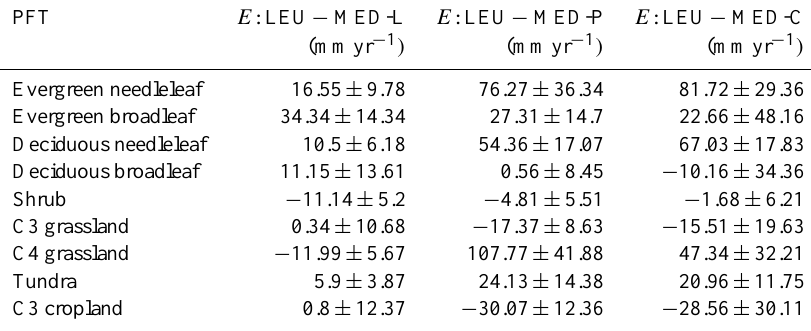
Figure 9. Latitudinal average (December-January-February: DJF and June-July-August: JJA) of mean annual (a, b) gross primary produc- tivity (GPP) and (c, d) evapotranspiration (ET) predicted by the CABLE model compared to the upscaled FLUXNET and LandFlux-EVAL products. CABLE model simulations are shown are from the standard CABLE (LEU), the Medlyn model fit to the Leuning model (MED-L), Medlyn model with the g 1 PFT parameterisation (MED-P) and the Medlyn model with the g 1 parameter predicted as a function of climate indices (MED-C). The shading represents ± 1 standard deviation in the data product and ± 2 standard errors in the MED-P and MED-C models. Data shown cover the 10 years of the Global Soil Wetness Project2 (GSWP-2) forcing (1986–1995) period. In total, 126 out of a possible 54000 pixels have been masked from the zonal average of the MED-C model, which represents pixels where the temperature range and moisture index extended outside the range of the synthesis g s database. Missing data areas in the both data products have been also been excluded from any comparisons (for example over the Sahara Desert, see Zhang et al., 2013). Table 7. Mean and 1 standard deviation difference in annual E between the LEU and MED-L model, the LEU and MED-P models and the LEU-C models for each of CABLE’s PFTs. Where standard deviations are large relative to the mean it suggests large variability between the LEU and other models within a